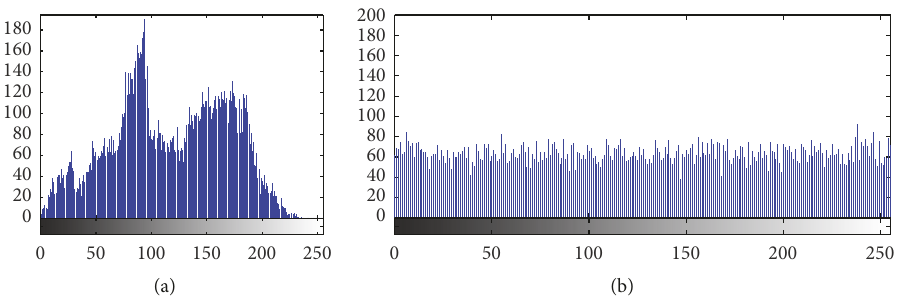
Figure 8: Histograms of original and encrypted